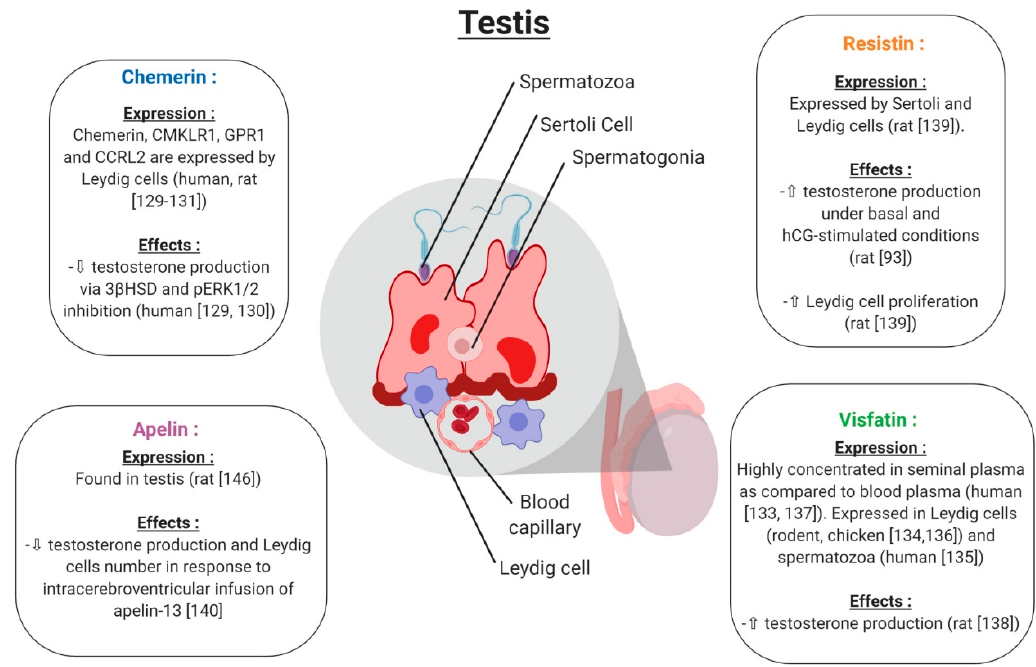
Figure 6. Expression and effects on GnRH (Gonadotropin-Releasing Hormone) release of chemerin, visfatin, resistin and apelin in hypothalamus. ⇧ Increase/stimulation. ⇩ Decrease/inhibition. ND: not determined. CSF: cerebrospinal fluid.